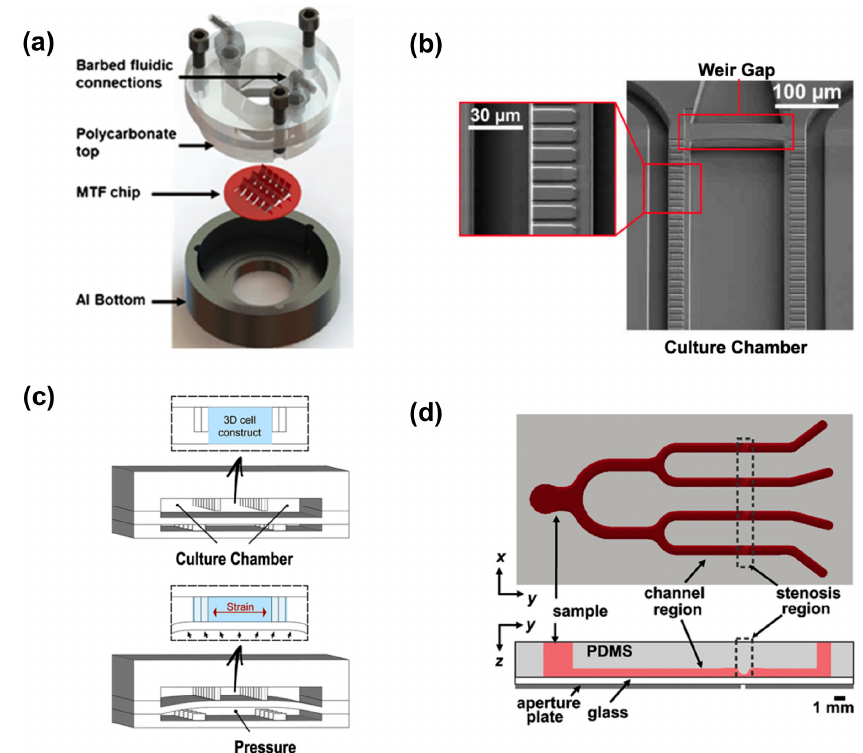
Figure 2. Cardiovascular organs-on-a-chip. ( a ) Exploded view of heart-on-a-chip device. Adapted from [96] with permission from The Royal Society of Chemistry. ( b ) Scanning electron micrograph of the microphysiological system. Red rectangular boxes show the 2 mm endothelial-like barrier and the weir gap. Adapted with permission from [103]. ( c ) Schematic of the 3D beating heart-on-a-chip microdevice. The polydimethylsiloxane (PDMS) membrane between compartments deforms, compressing the 3D cell construct. Adapted from [87] with permission from The Royal Society of Chemistry. ( d ) Schematic showing top and side view of the microfluidic device for inducing platelet aggregation at four distinct high shear stenotic regions. Adapted with permission from [104].